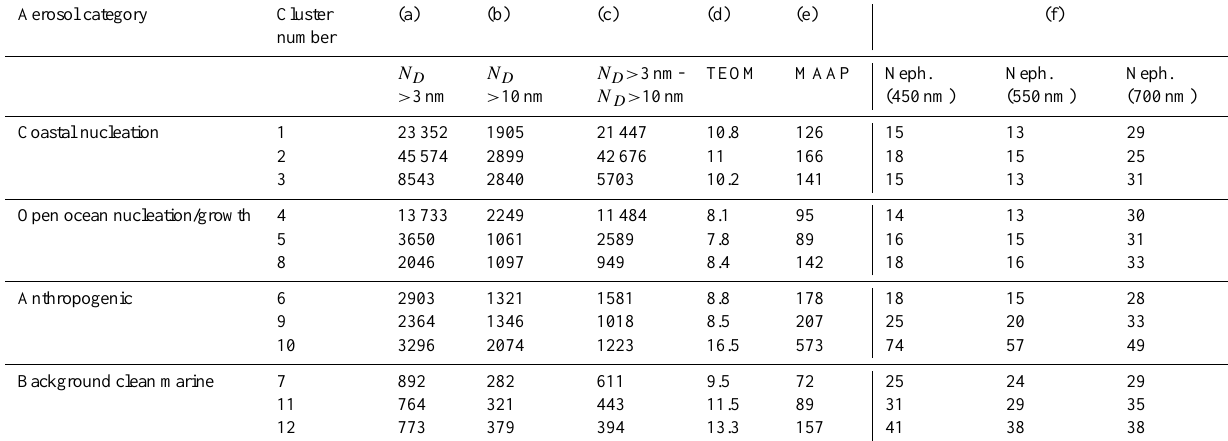
Table 3. Average CPC particle number concentration for each of the 12 SMPS clusters: (a) N D > 3nm (CPC TSI 3025A) [cm − 3 ] ,